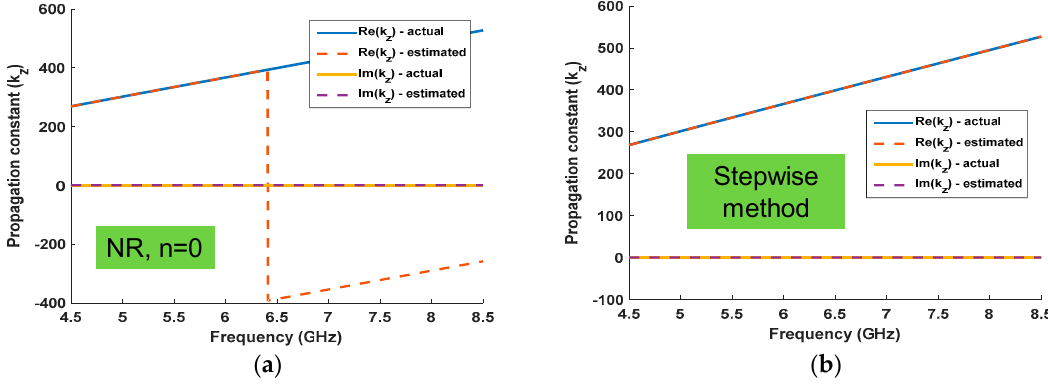
Figure 5. Propagation constant of the medium with NRW with n = 0 ( a ) and with the stepwise method ( b ).